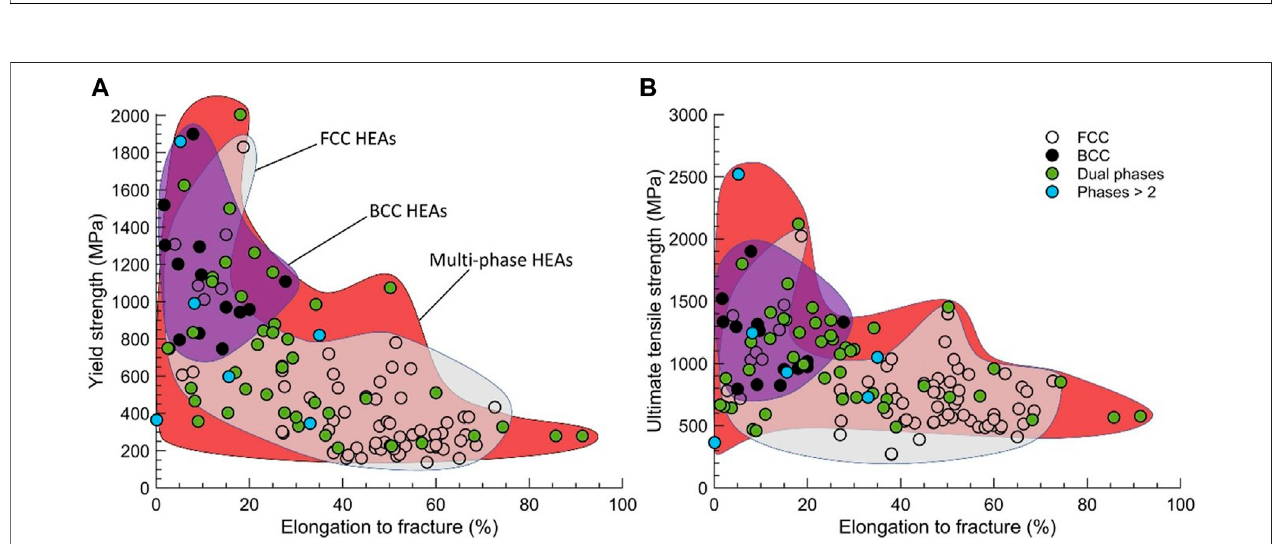
FIGURE3| Propertymapsof (A) tensileyieldstrengthand (B) ultimatetensilestrengthversuselongationtofractureofHEAs,groupedbyphasestructures(Lietal., 2021).